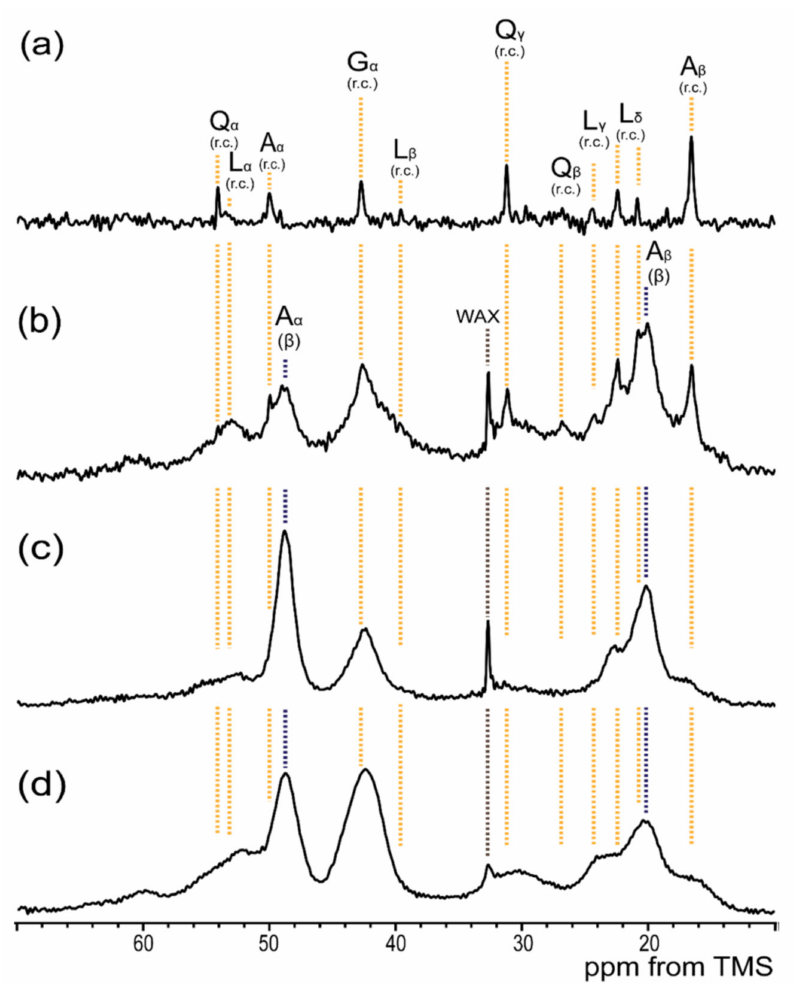
Figure 13. Expanded 13 C solid-state NMR spectra (10 − 70 ppm) of N. clavata dragline silk fibers together with assignments: ( a ) 13 C refocused INEPT, ( b ) 13 C DD / MAS, and ( c ) 13 C CP / MAS spectra in the hydrated state and ( d ) 13 C CP / MAS spectrum in the dry state